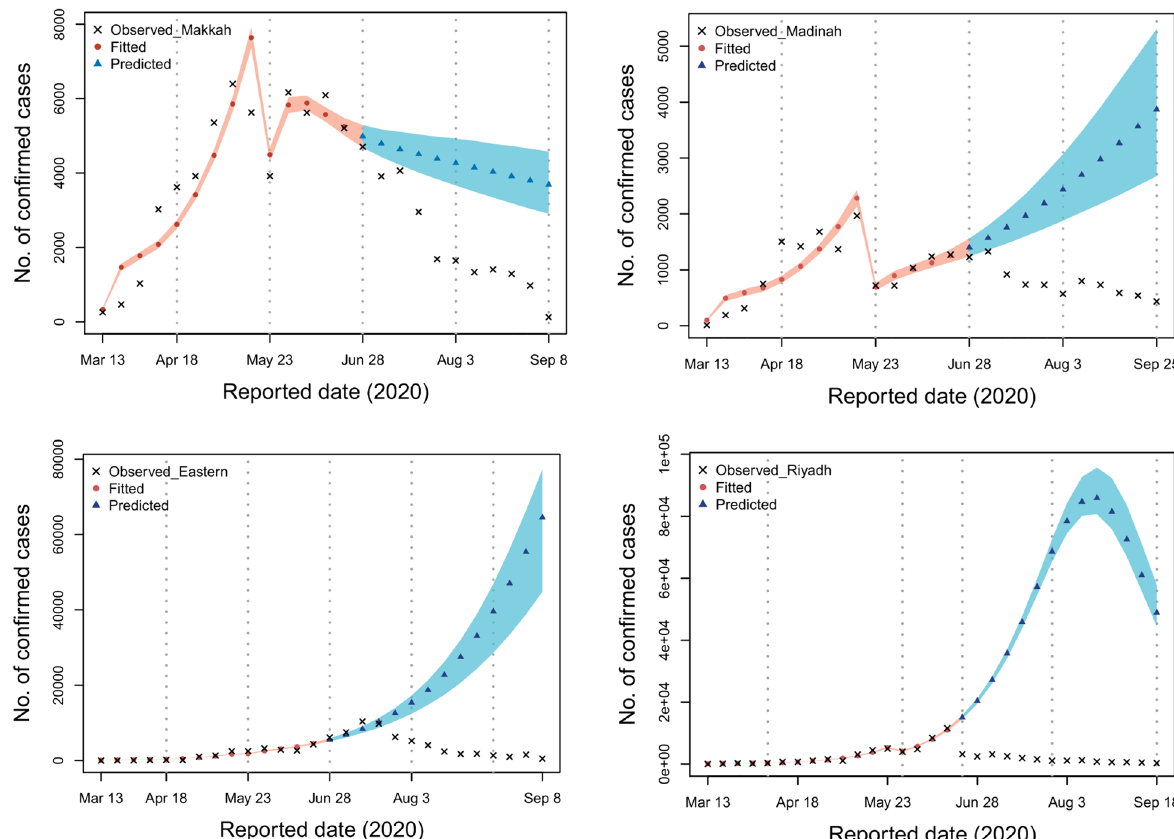
Figure 5. For each of the four areas of interest, the relevant parameters were estimated by first fitting the data of each region and then predicting using the parameters from period 3. This was carried out for each of the four areas of interest